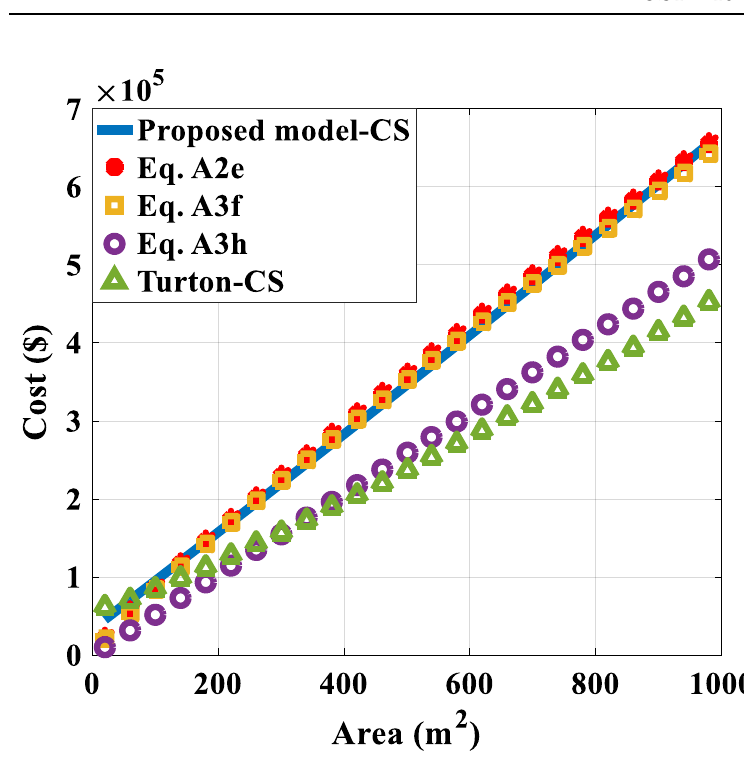
Figure 6. Air cooler cost against area [28,52 – 54].